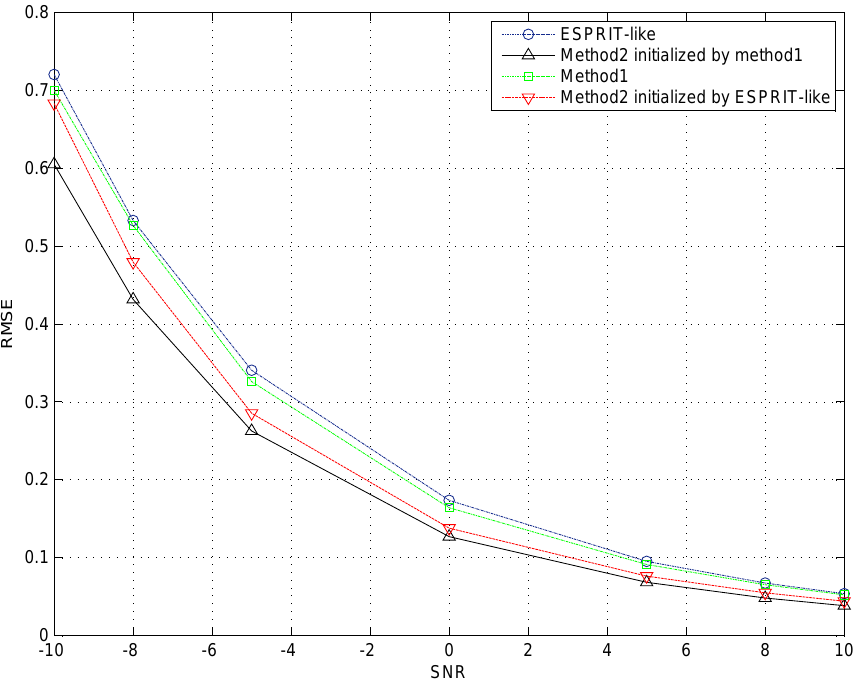
Figure 2. RMSE of the spatial signature matrix V estimation versus SNR. The number of snapshots N = 500